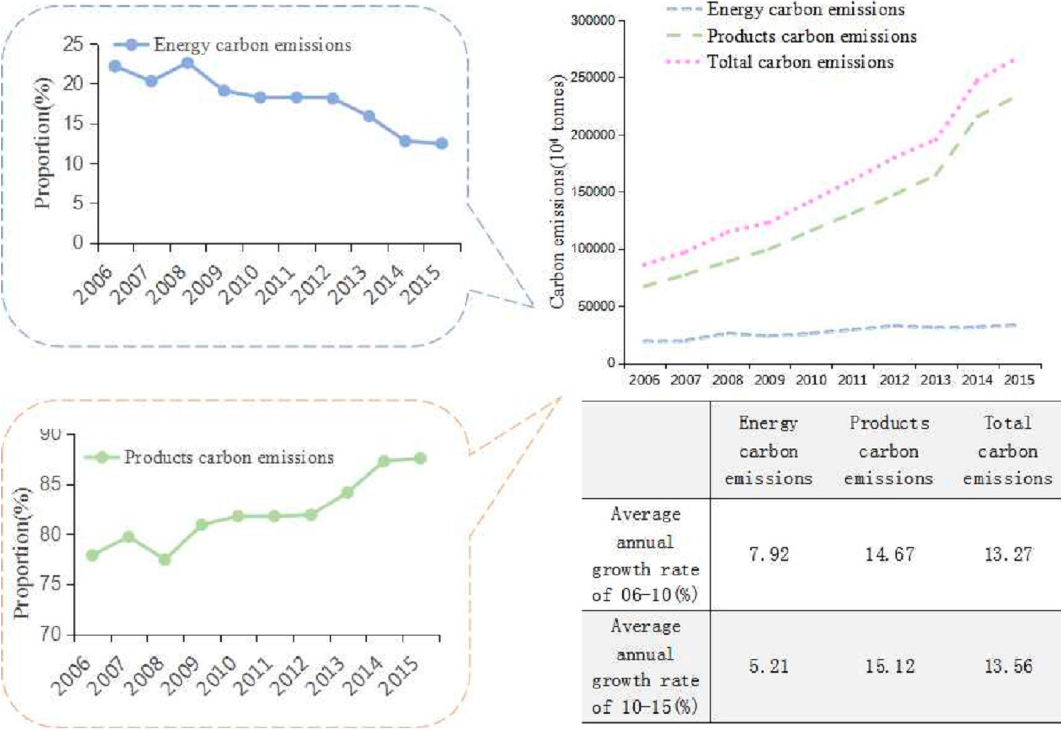
Figure 2. The scale and structural change of the total carbon emissions of China’s household consumption from 2006 to 2015.